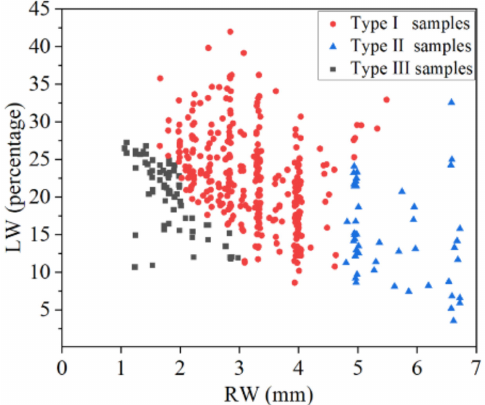
Figure 2. The relationship between latewood (LW) percentage and ring width